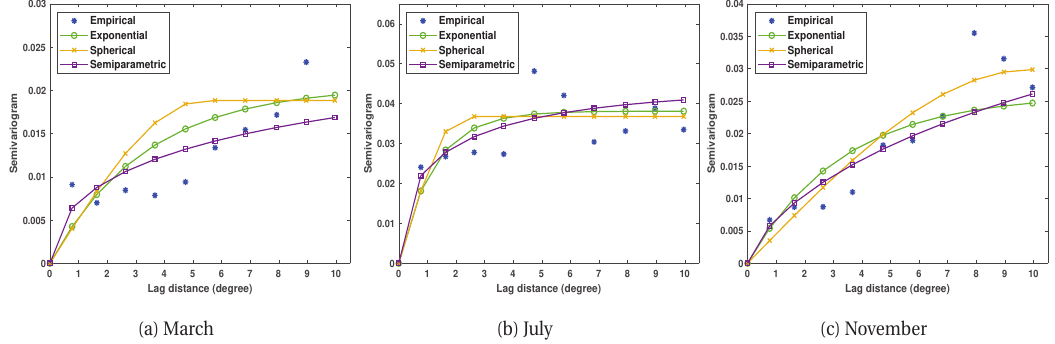
Figure 5. A comparison of three different semivariograms for March, July and November in Fold 4.